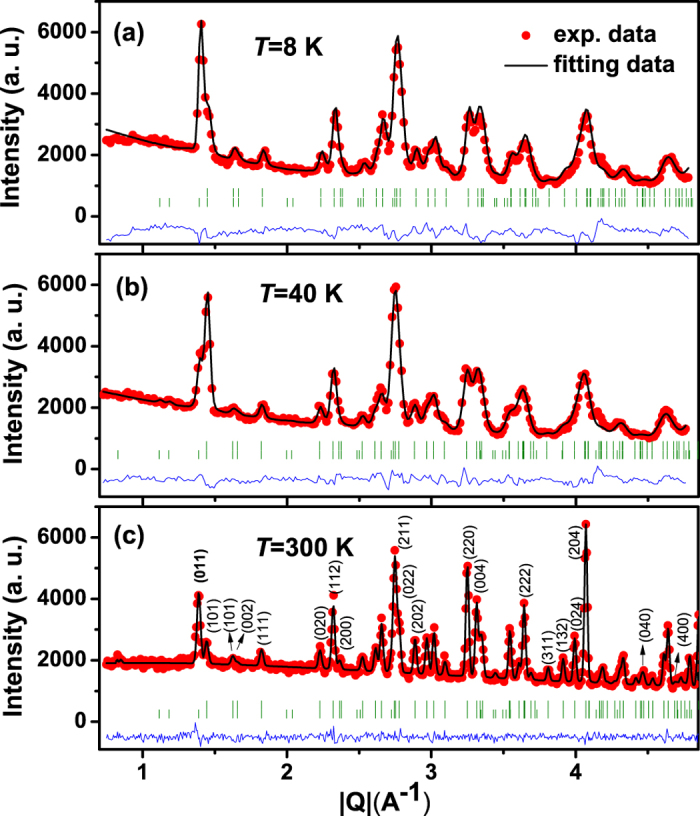
NPD patterns for TbFe1−xMnxO3 with x = 0.25 sample, obtained at (a) T = 8 K, (b) T = 40 K and (c) T = 300 K, respectively. The two lines of vertical bars present Bragg peaks for the crystal structures and the crystal with magnetic structures of Fe3+/Mn3+ respectively.